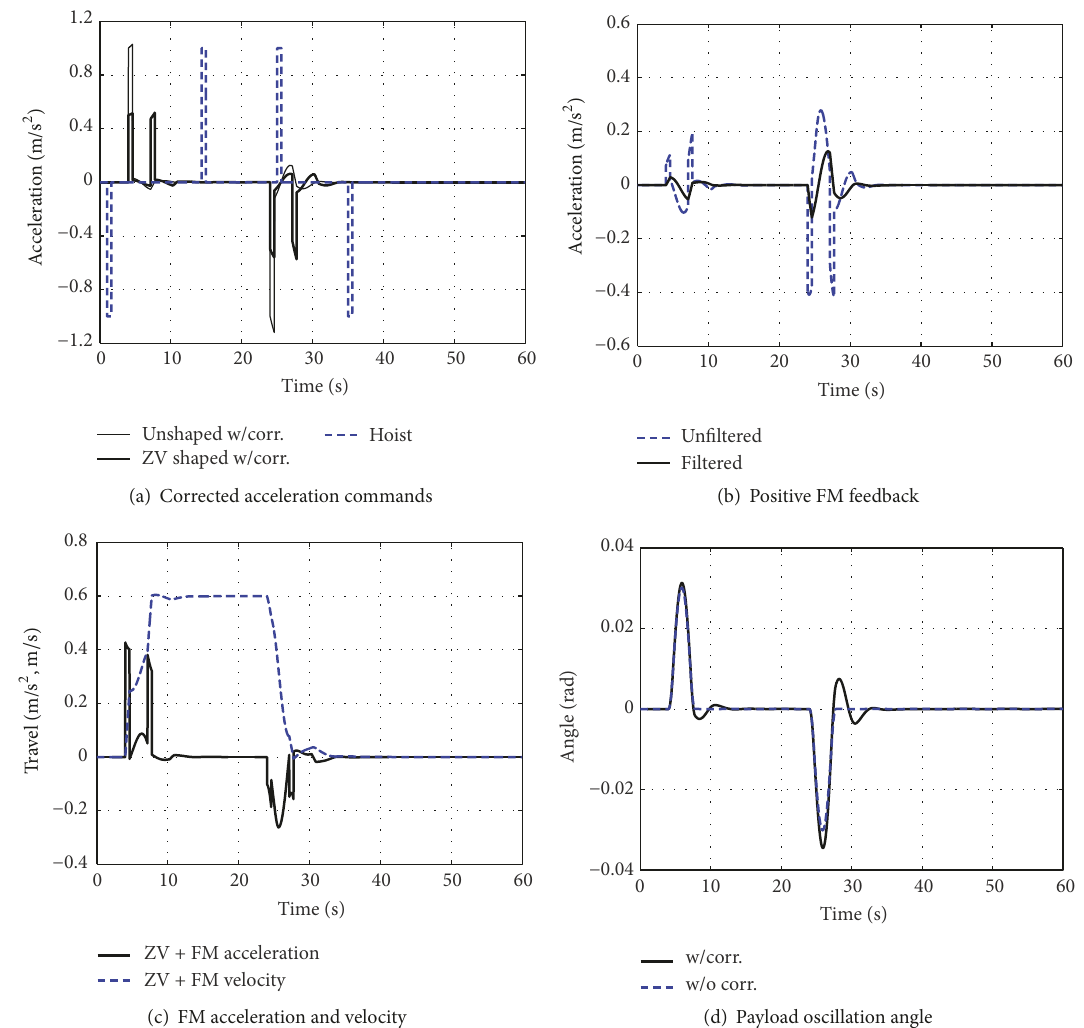
Figure 9: Simultaneous travel and hoisting maneuver using modified FM shaping with primary ZV input shaper.